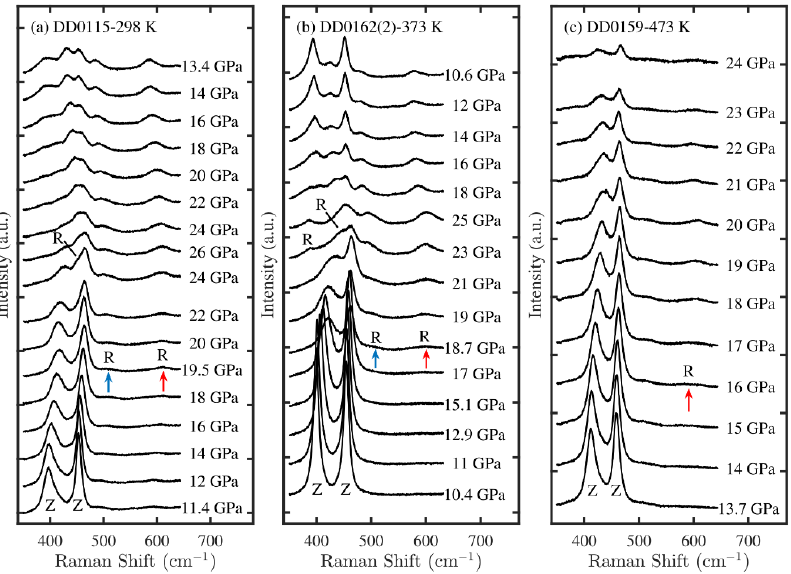
Figure 2. The characteristics of zircon Raman spectra at different pressures for ( a ) DD0115, ( b ) DD0162(2), and ( c ) DD0159. The peaks of zircon and reidite are marked by Z and R, respectively. The blue and red arrows denote the novel peaks that are attributed to the vibrational modes of reidite B g (3) and E g (4), respectively.